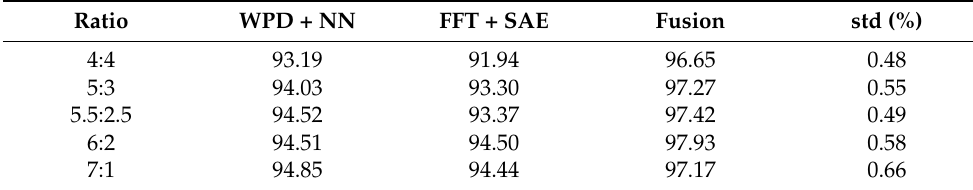
Table 3. The accuracy (%) table with different parameters.